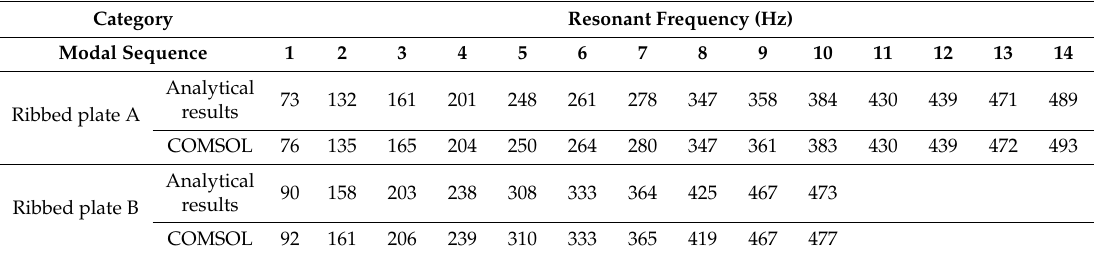
Table 3. The resonant frequencies of the ribbed plate A and B below 500 Hz.